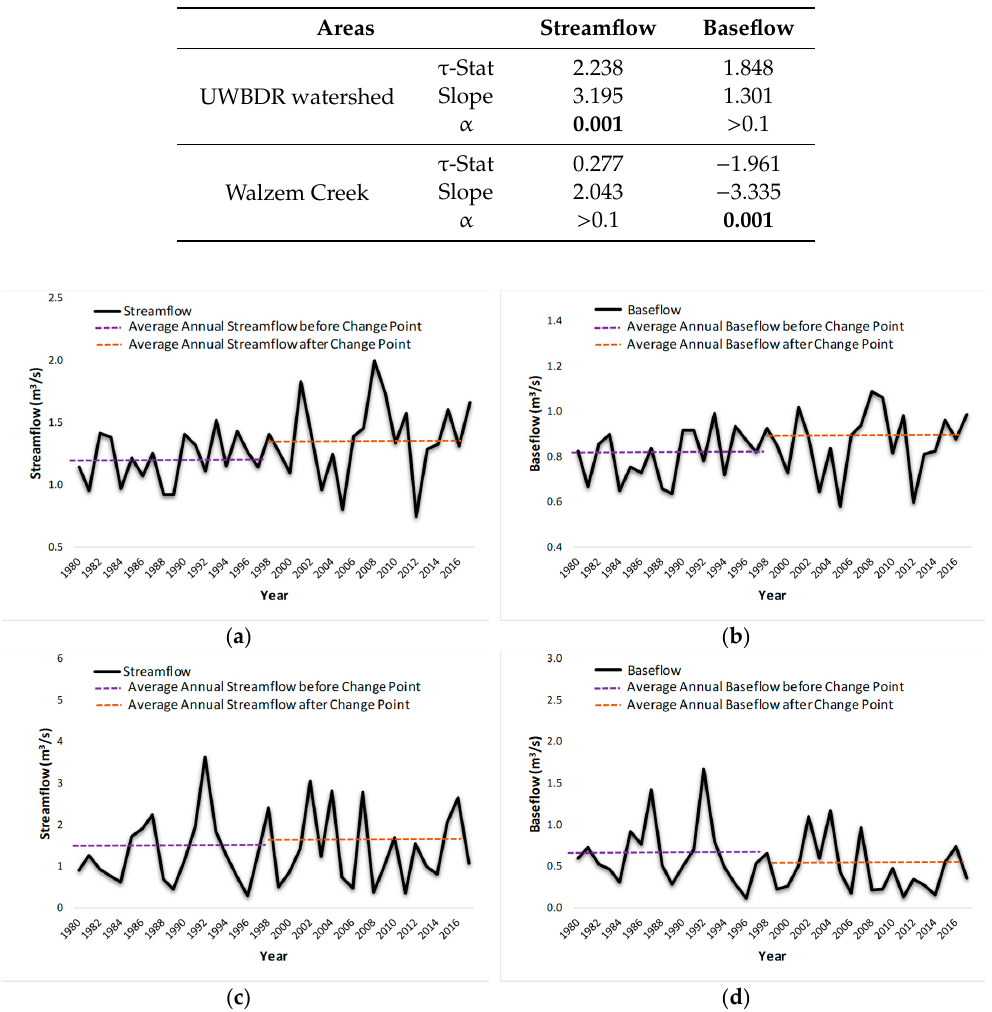
Figure 3. The MK trends for average daily streamflow ( a ) and baseflow ( b ) in the UWBDR watershed; and average daily streamflow ( c ) and baseflow ( d ) in the Walzem Creek watershed.